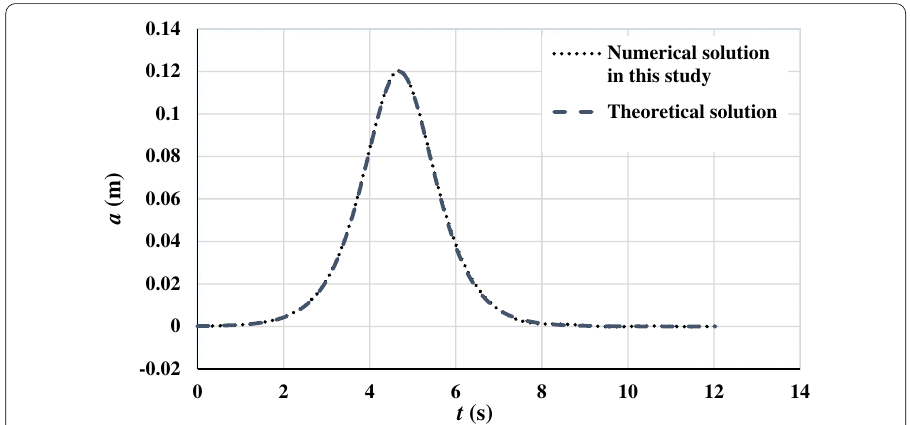
Fig. 3 Comparison of wave heights of solitary waves generated by the numerical method and the theoretical method (at x 5 m) =